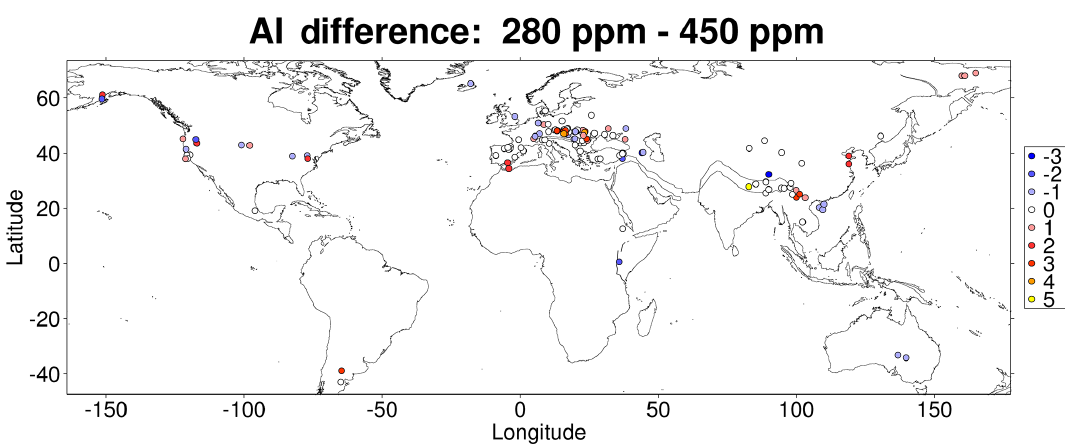
Figure 5. Agreement index difference between the 280 and 450ppm